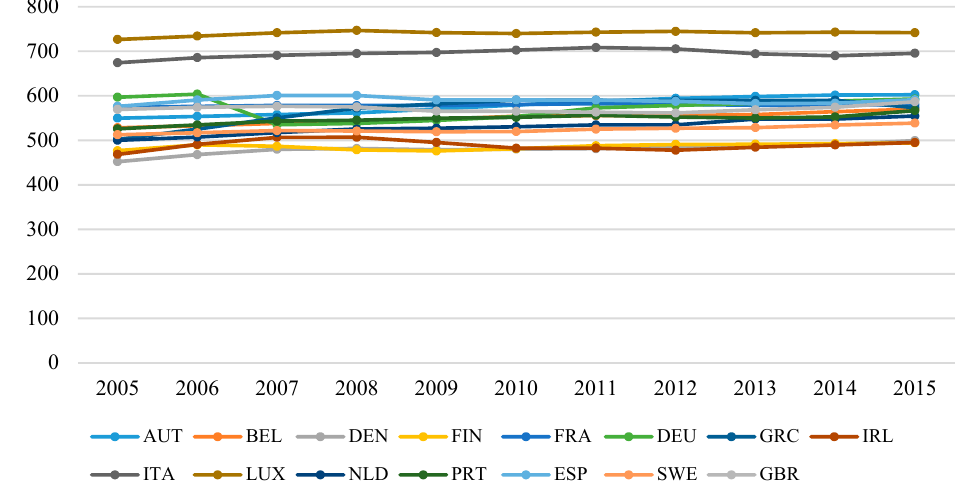
Figure 2. Annual vehicle ownership per 1000 people of EU15. Source : OICA .